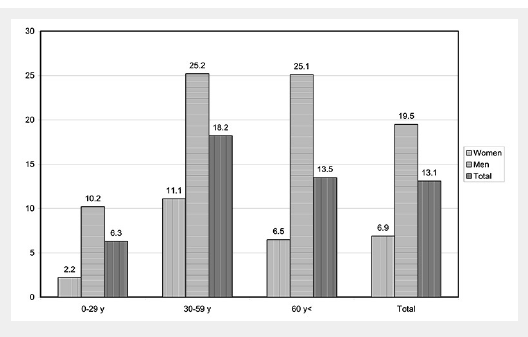
Suicide rate per 100,000 inhabitants and year by age group and sex, excluding assisted suicides (n =